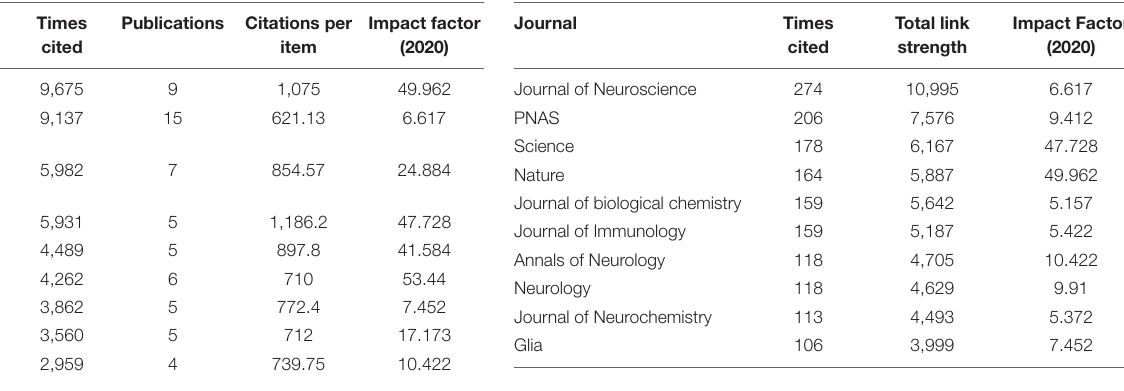
TABLE 5 | List of the top 10 cited journals. TABLE 6 | List of the top 10 cited journals in the references.